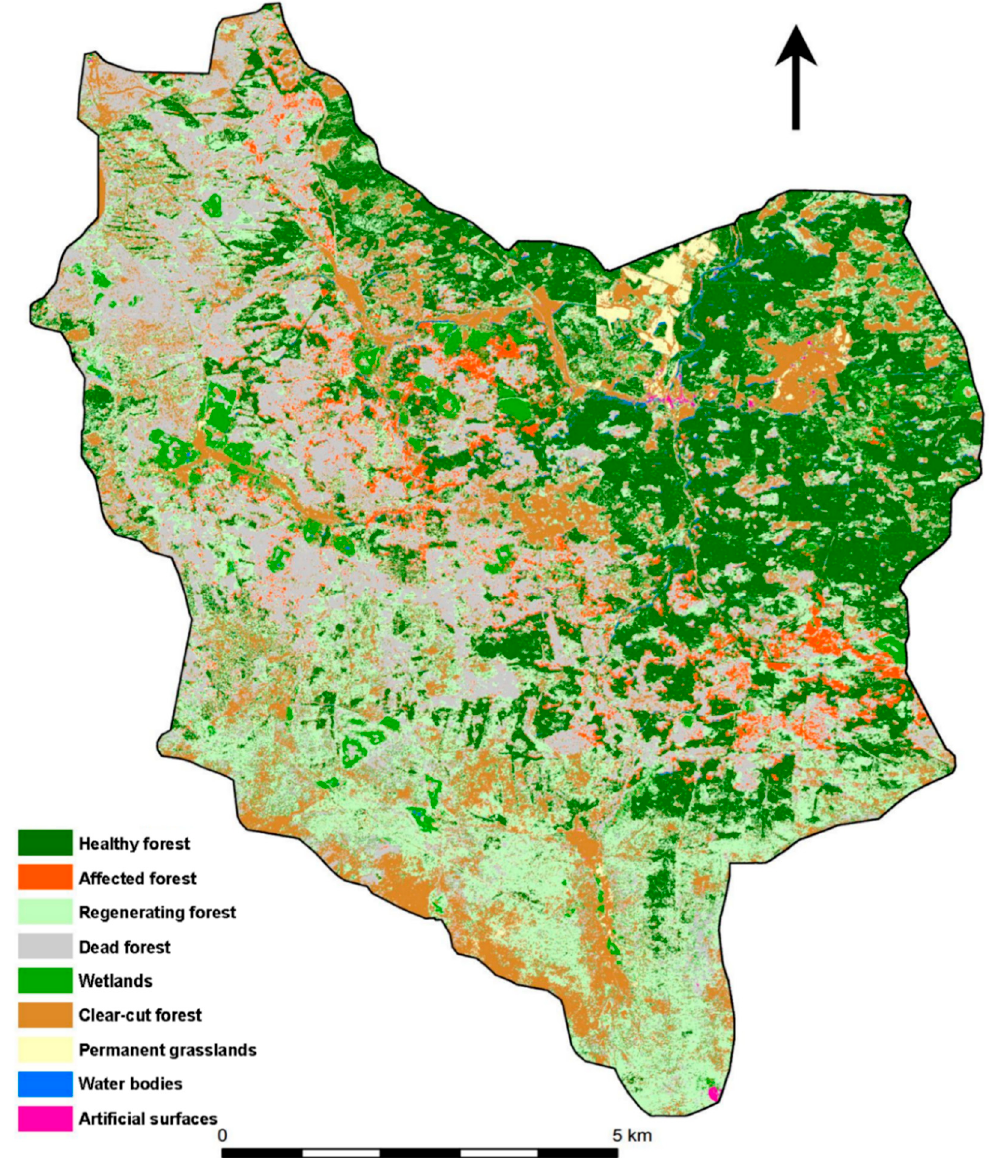
Figure A10. Classification SVM, WorldView-2, 2016, NP Sumava.